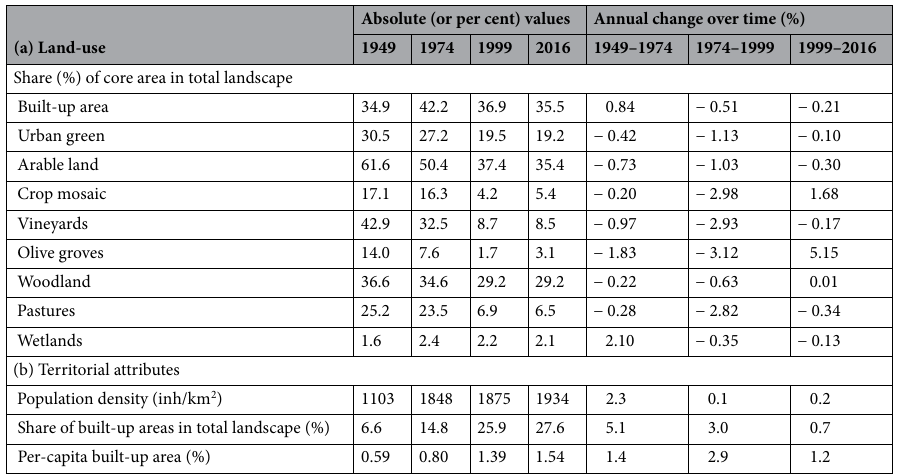
Table 1. Per cent share of ‘core’ area in total landscape by land-use class in metropolitan Rome (panel a) and selected territorial variables, 1949–2016 (panel